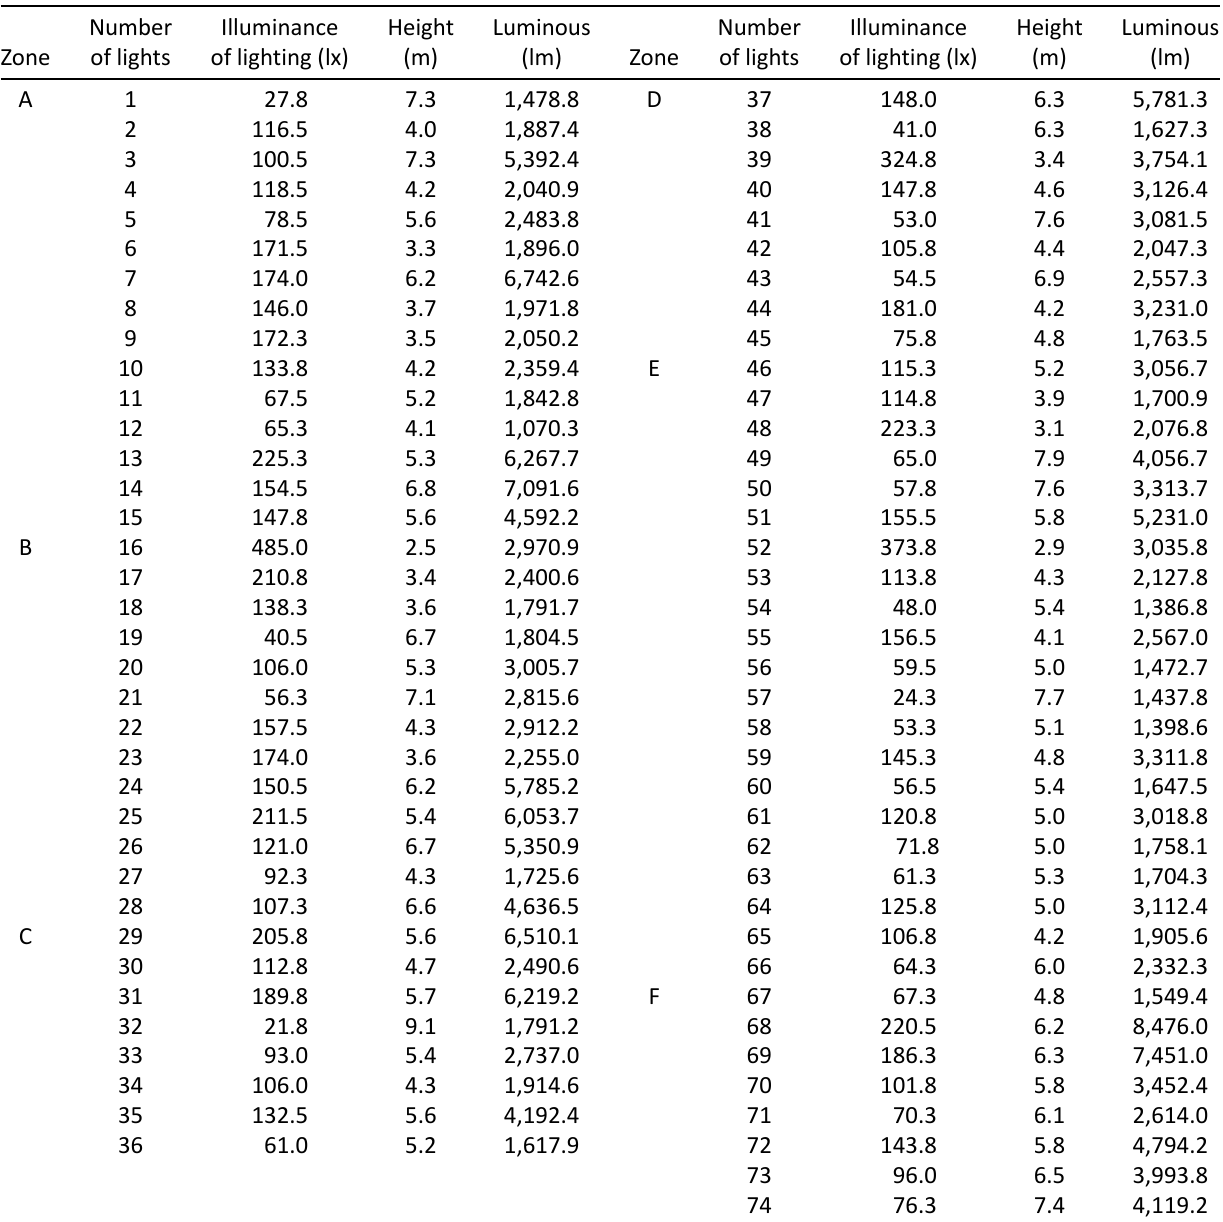
Table 1. Lighting